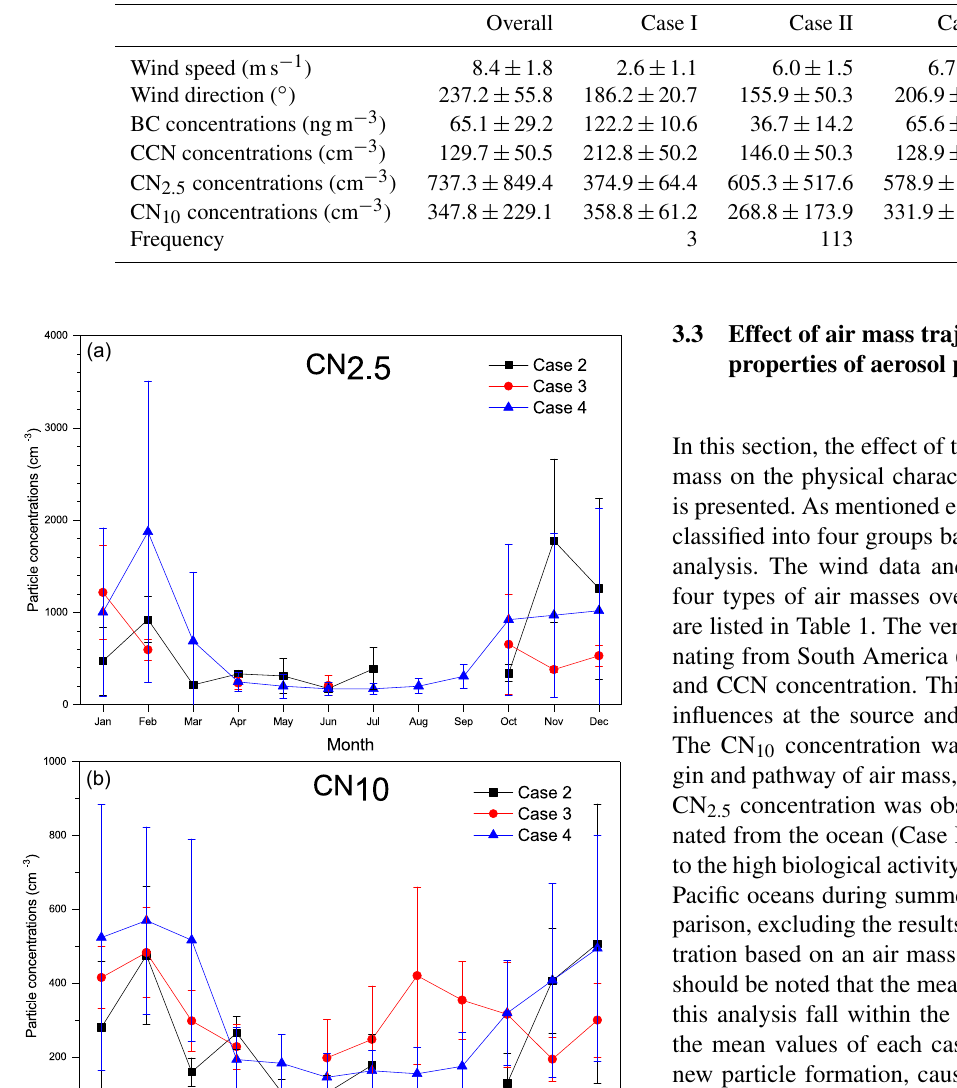
Table 1. Summary of meteorology and aerosol data according to the origin and transport pathway of aerosol particles. Case I, Case II, Case III, and Case IV refer to the origin and pathway of the air masses from South America, South Atlantic Ocean, Antarctica and South Pacific Ocean, respectively.